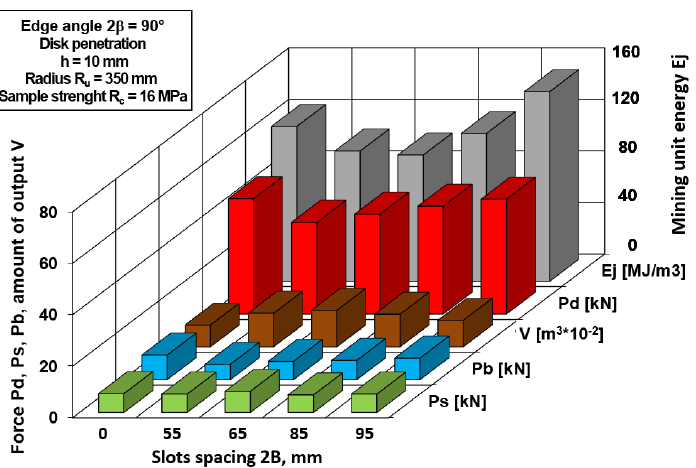
Figure 19. The value change of the pressure force Pd, tangential force Ps and side force Pb, the amount of output V and the mining unit energy Ej as a function of slots spacing 2 B for depth of slots g = 10 mm [1] .